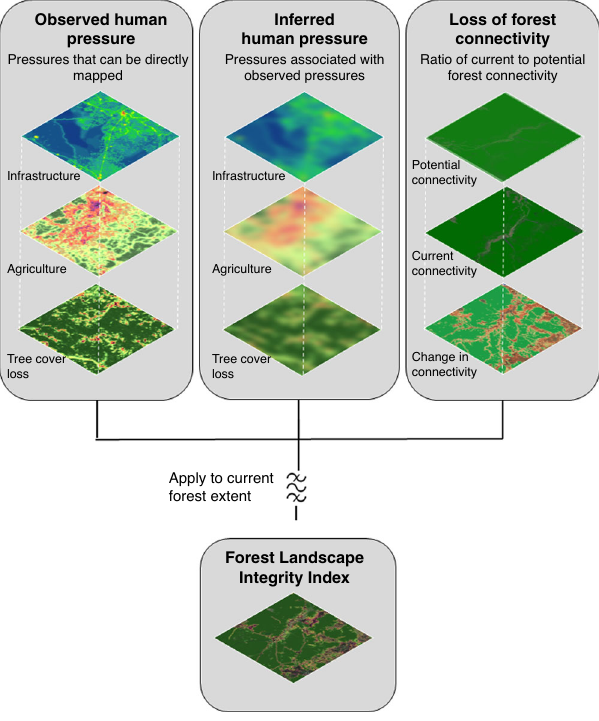
Fig. 1 Methods used to construct the Forest Landscape Integrity